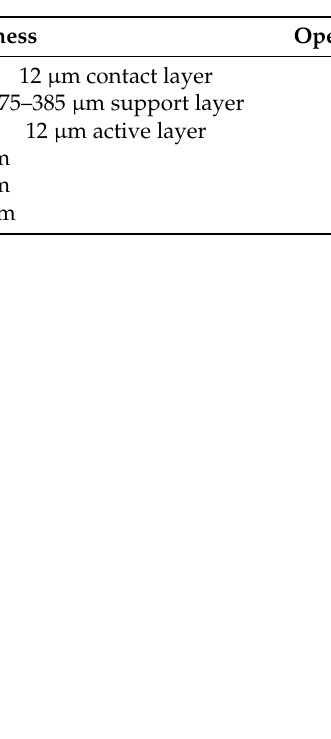
Table 1. The materials and thicknesses of all the layers of button cells.